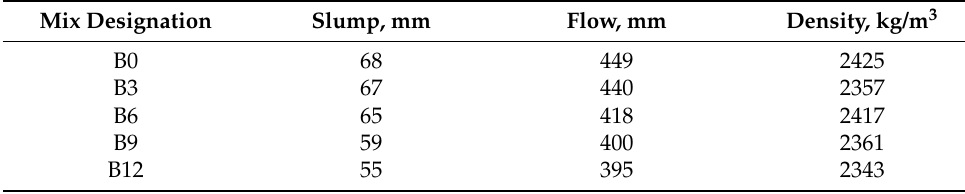
Table 5. Slump, flow, and density values of fresh concrete mixtures containing ash.